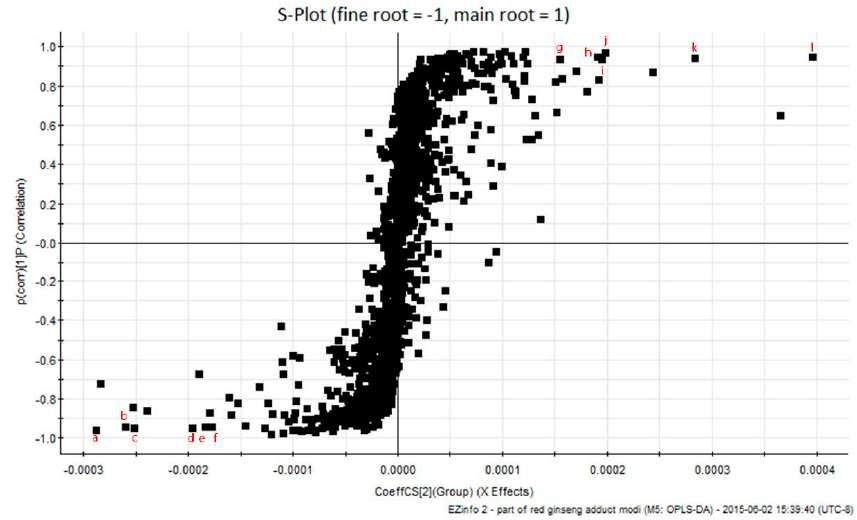
Figure 3. OPLS-DA S-plot between main root and fine root, using Pareto scaling with mean centering.